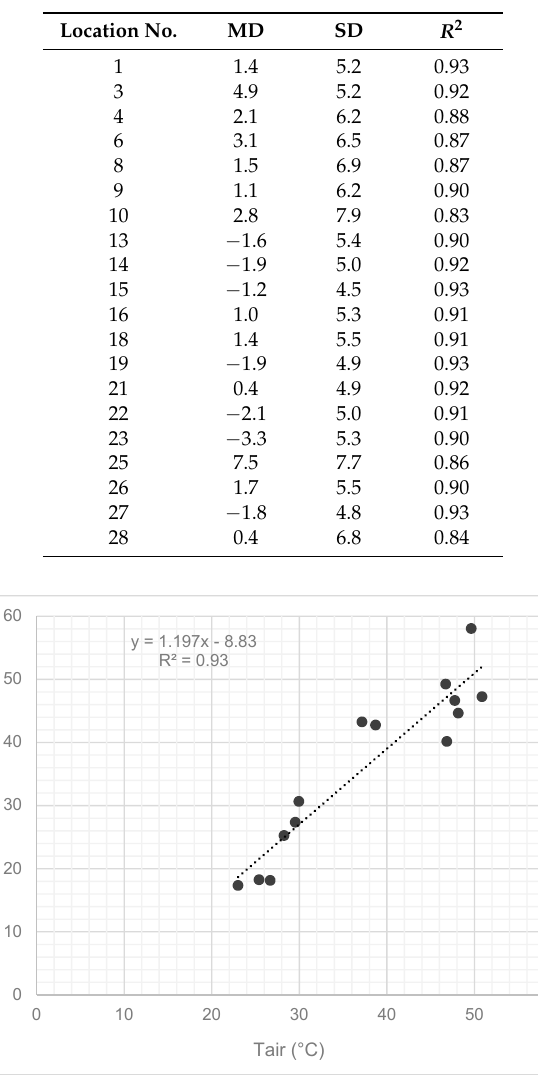
Figure 4. Scatterplot of T air and 2017 Landsat LST image data (for measurement location 1) in Ford Dry Lake.